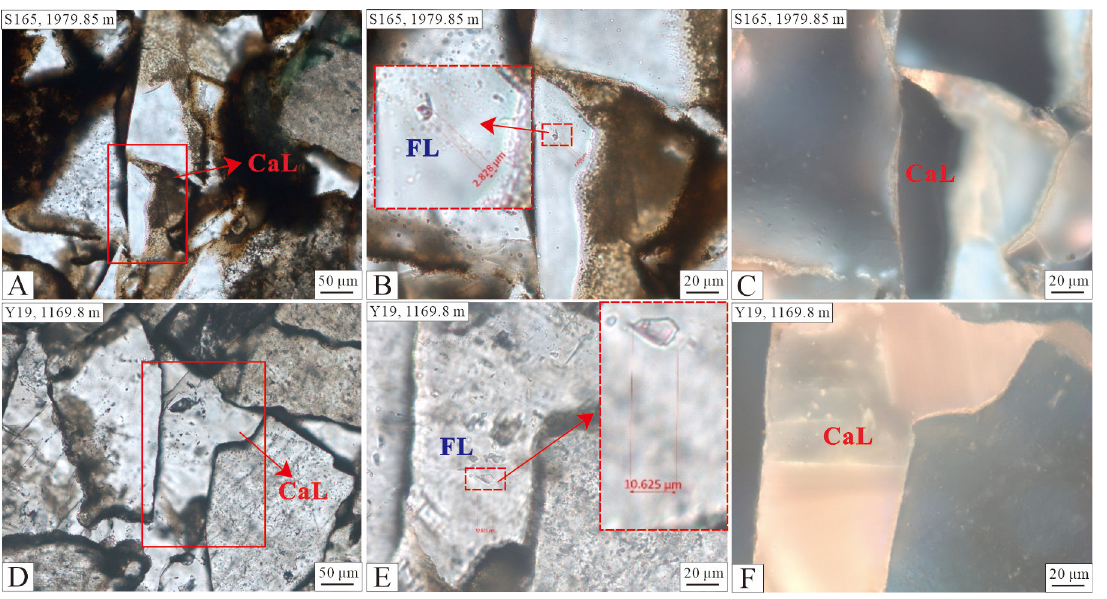
Figure 11. Photomicrographs of typical fluid inclusions in calcite cements at room temperature. ( A – C ) Sample from S165 (1979.85 m). ( A ) suggesting type-II calcite cements under plane-polarized light and ( B ) is an image under cross-polarized light and ( C ) is an image under fluorescent light. ( D – F ) Sample from Y19 (1169.8 m). ( D ) suggesting type-II calcite cements under plane-polarized light and ( E ) is an image under cross-polarized light and ( F ) is an image under fluorescent light.